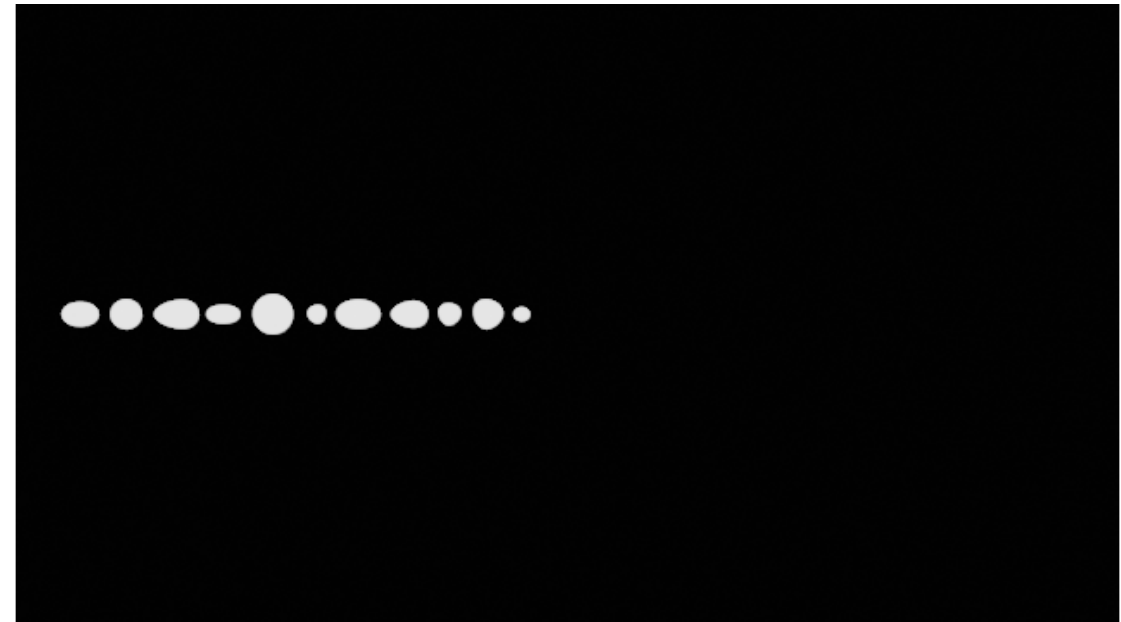
Figure 5. The image mask generated sample at the render stage.